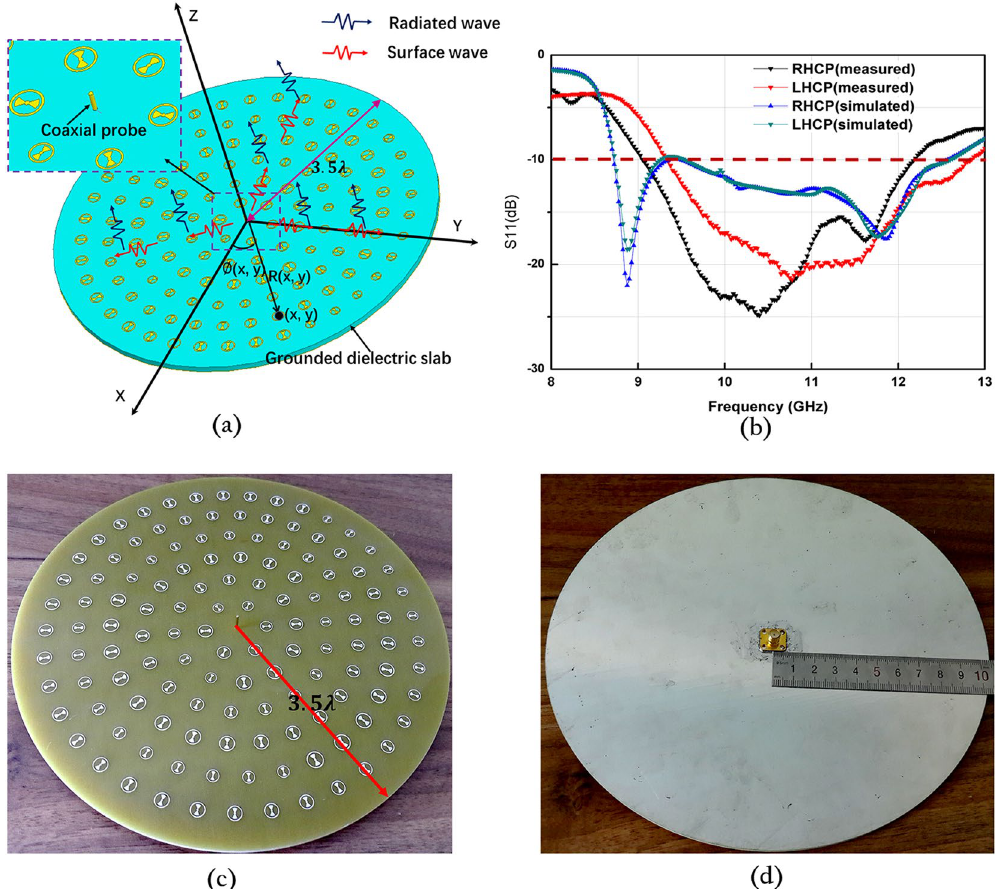
Figure 3. ( a ) Configuration of the proposed MA. Red zigzag lines represent the surface wave excited by coaxial probe, and black zigzag lines represent electromagnetic wave radiated by RBUs. φ (x, y) is the azimuthal angle of position (x, y). ( b ) Front view of the fabricated MA. ( c ) Rear view of the fabricated MA. ( d ) Simulated and measured reflection coefficients of LHCP and RHCP